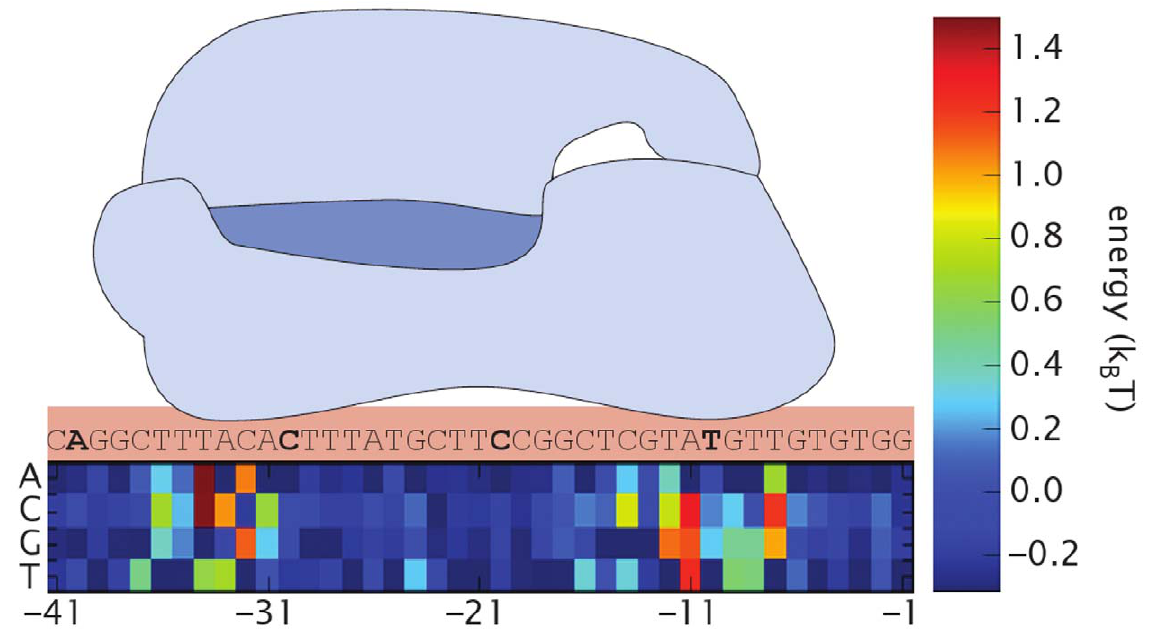
Figure 2. Energy matrix for RNAP binding. Figure adapted from Kinney et al [20]. The contribution of each basepair to the total binding energy is represented by color. The total binding energy of a particular sequence can be calculated by summing the contribution from each base pair. Positive values indicate disfavorable contributions to binding energy. As expected, the most influential base pairs are those in the { 10 and { 35 region which interact directly with the binding domains of RNAP s 70 . Numeric matrix entries are available in SI Text S2. The sequence displayed above the energy matrix corresponds to the wild-type lac promoter; the bold bases mark 10 base pair increments. x { axis coordinates are with respect to the transcription start site.